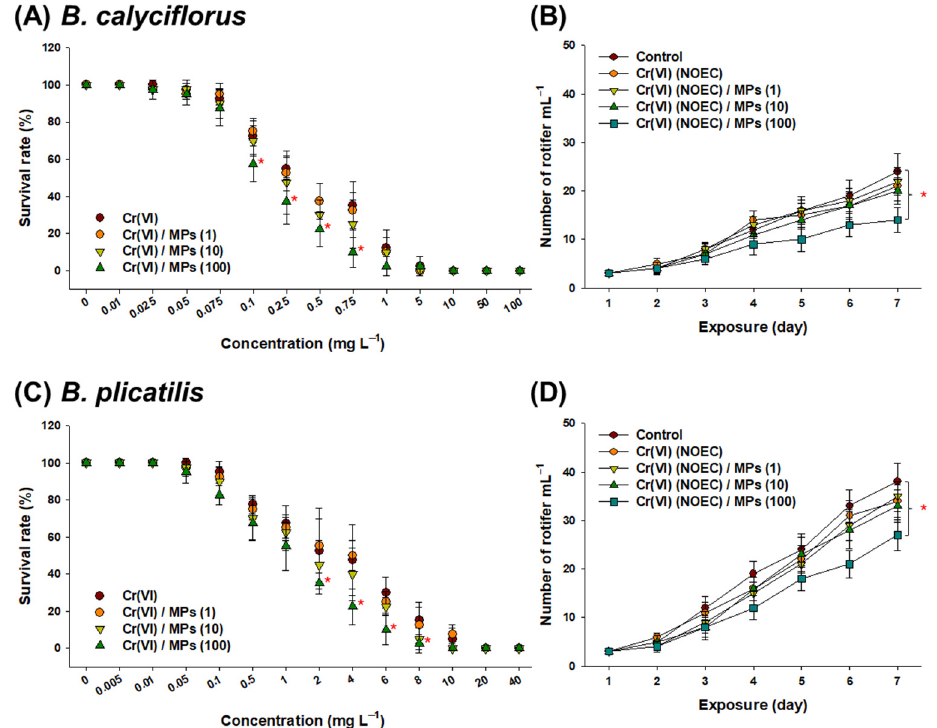
Figure 1. Results of acute toxicity in rotifers. Measurement of the 24 h survival rate of ( A ) B. calyciflorus and ( C ) B. plicatilis in response to different concentrations of Cr(VI) (0–100 mg L − 1 for B. calyciflorus and 0–40 mg L − 1 for B. plicatilis ) and the combination of Cr(VI) and 1 µ m MPs (1, 10, and 100 particles L − 1 ). The number of ( B ) B. calyciflorus and ( D ) B. plicatilis during the 7 days of exposure to the NOEC value of Cr(VI) and the combination of Cr(VI) and 1 µ m MPs (1, 10, and 100 particles L − 1 ). Data are presented as mean ± standard deviation (S.D.) of four replicates (n = 10 per replicate). An asterisk (*) on each concentration or day indicates significant difference between the control and exposure groups ( p < 0.05).